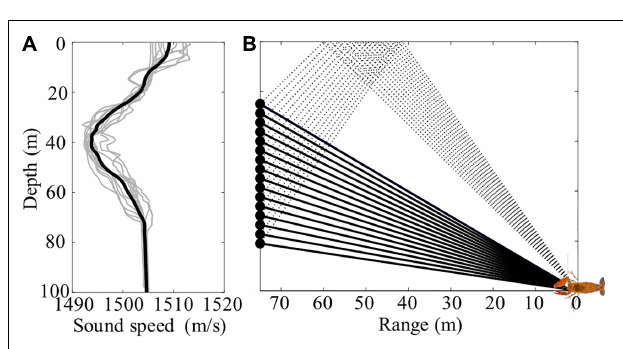
FIGURE 2 | (A) Sound speed profiles measured by 12 conductivity-temperature-depth (CTD) casts and their mean sound speed profile (thick line) during the experiment. (B) Ray diagram showing two representative ray paths of snap sound generated by a snapping shrimp. The solid and dotted lines indicate direct and sea surface-reflected paths,